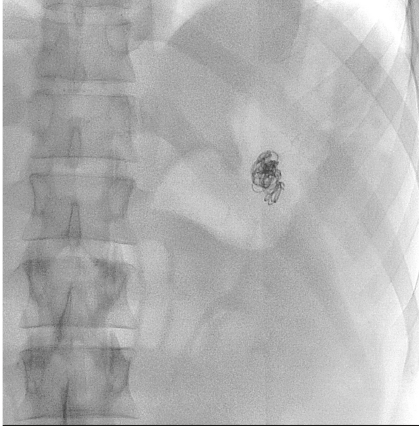
Figure 3: Final image of dense coil packing and thrombosis of the